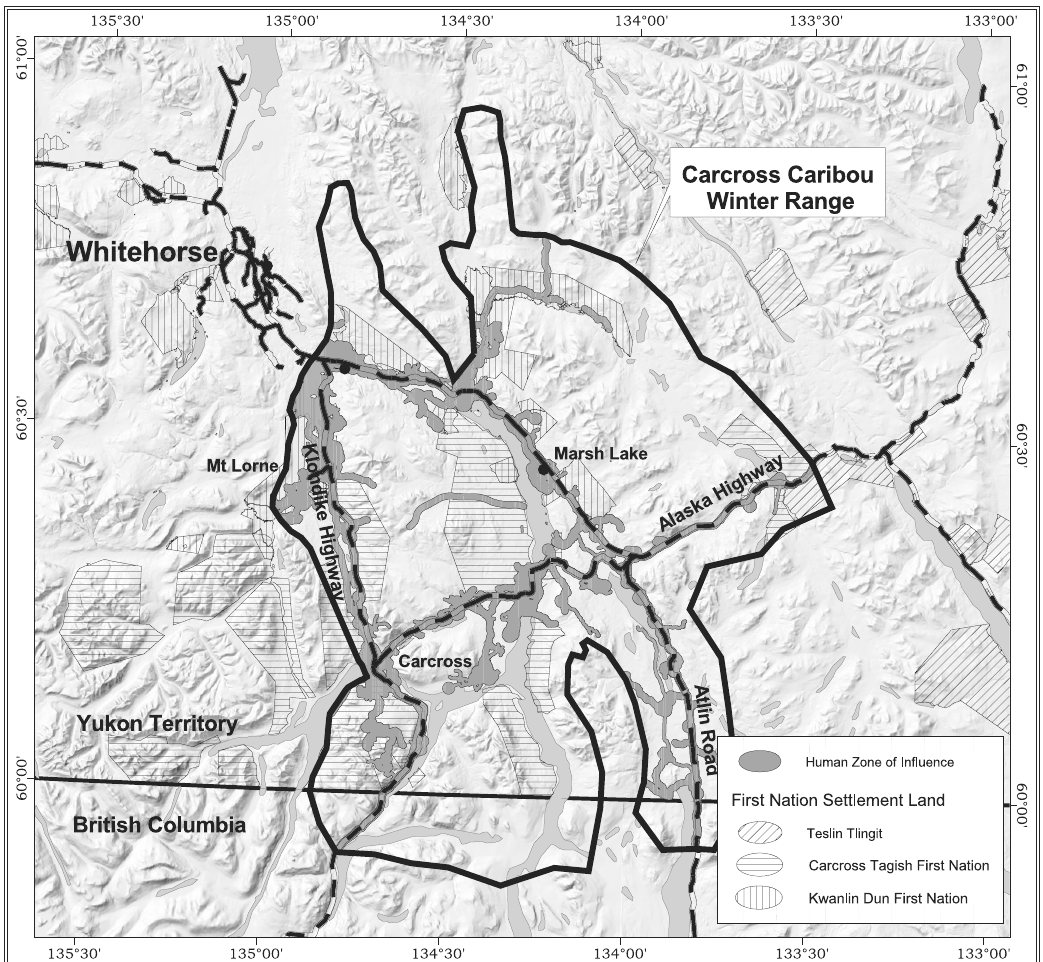
Fig. 2. Distribution of First Nation land selections, private land and estimated human Zone of Influence (ZOI) around development in the Carcross caribou winter